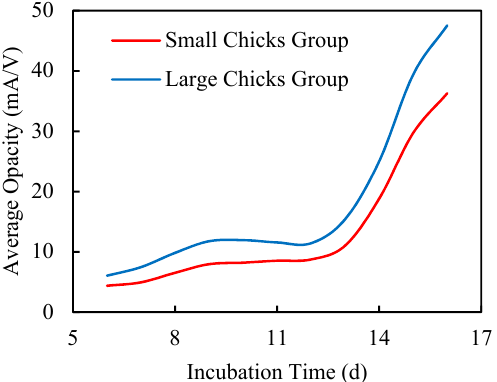
Figure 4. Growth pattern of small and large size chick groups during incubation (days 6 to 16).